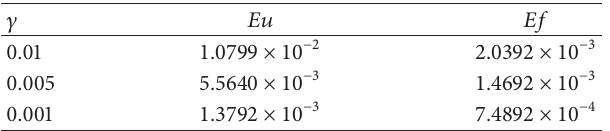
Table 2: The errors for different 𝛾 . Table 3: The errors for different 𝑞